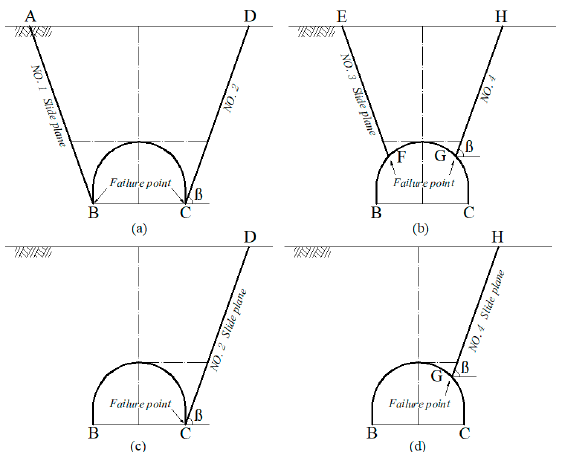
Figure 4. Four types of the slide surface: ( a ) The first type of slide surface; ( b ) The second type of slide surface; ( c ) The third type of slide surface; ( d ) The fourth type of slide surface.